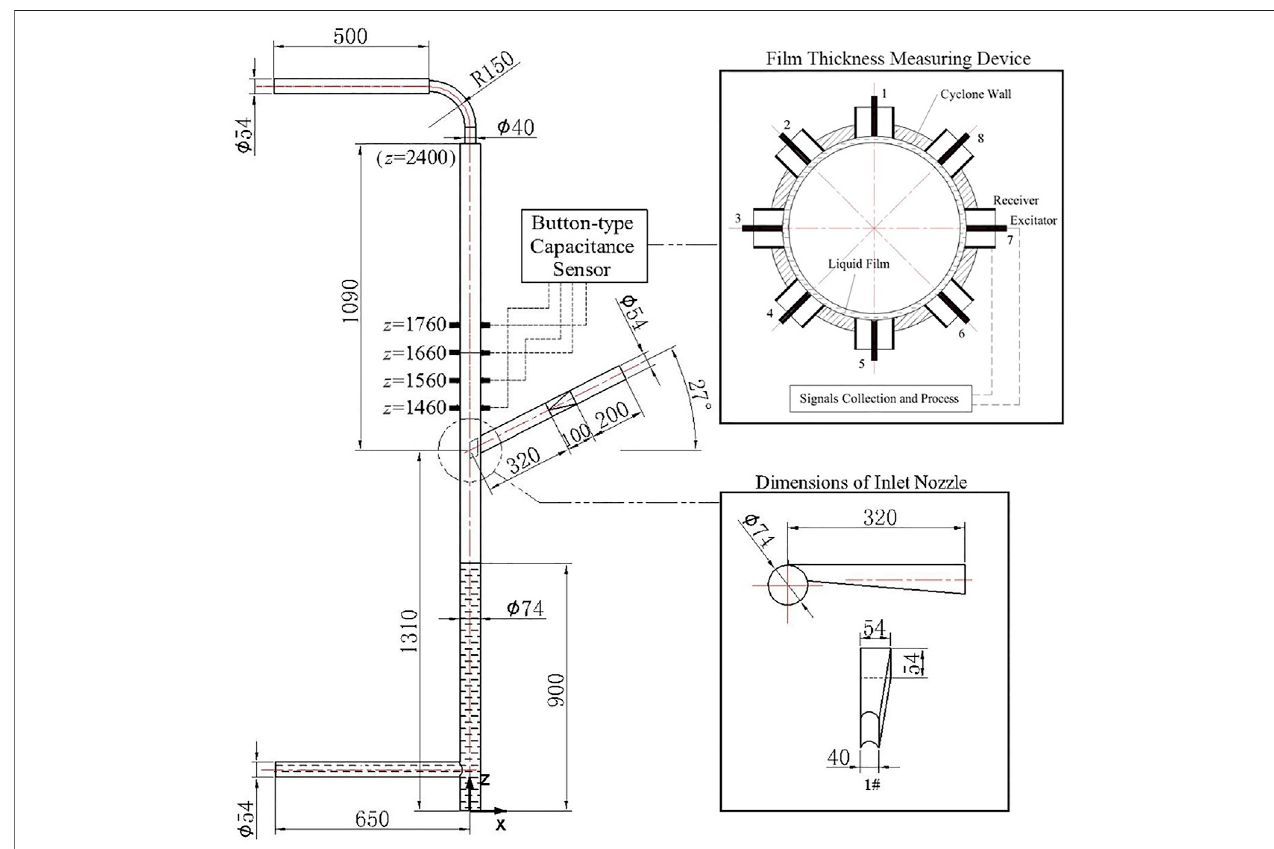
FIGURE 3 | Dimensions of the simulated GLCC (the liquid level = 900 mm) and Schematic diagram of button-type capacitance fi lm thickness measuring device.